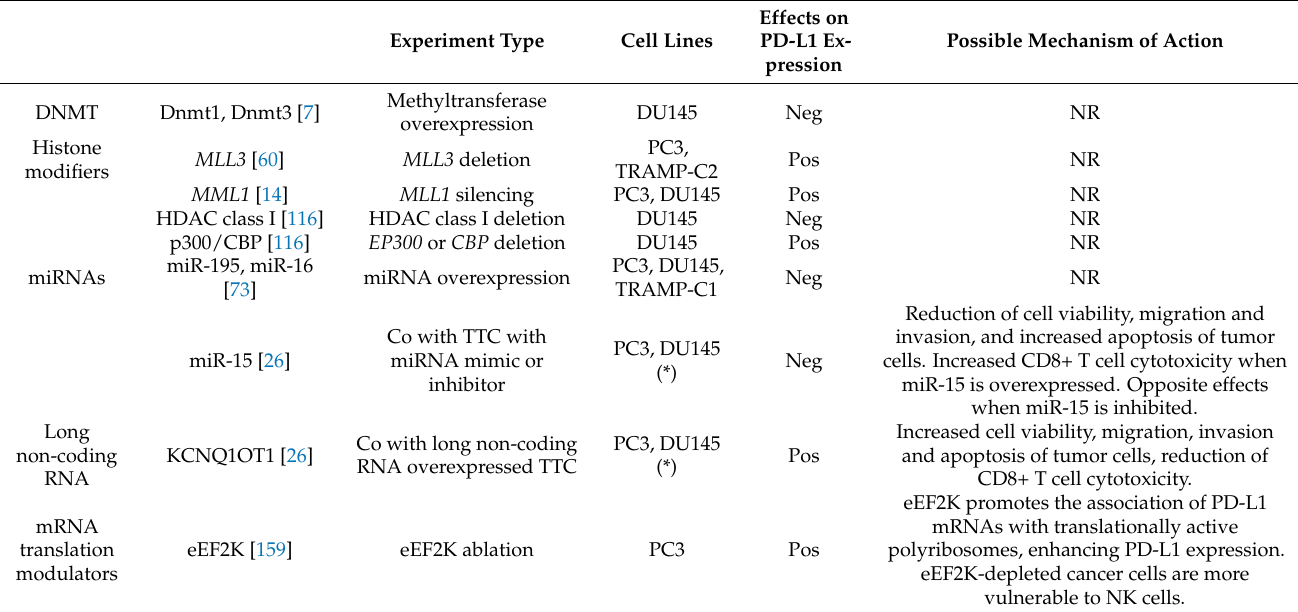
Table 1. PD-L1 epigenetic regulation in prostatic carcinoma-derived cell lines.